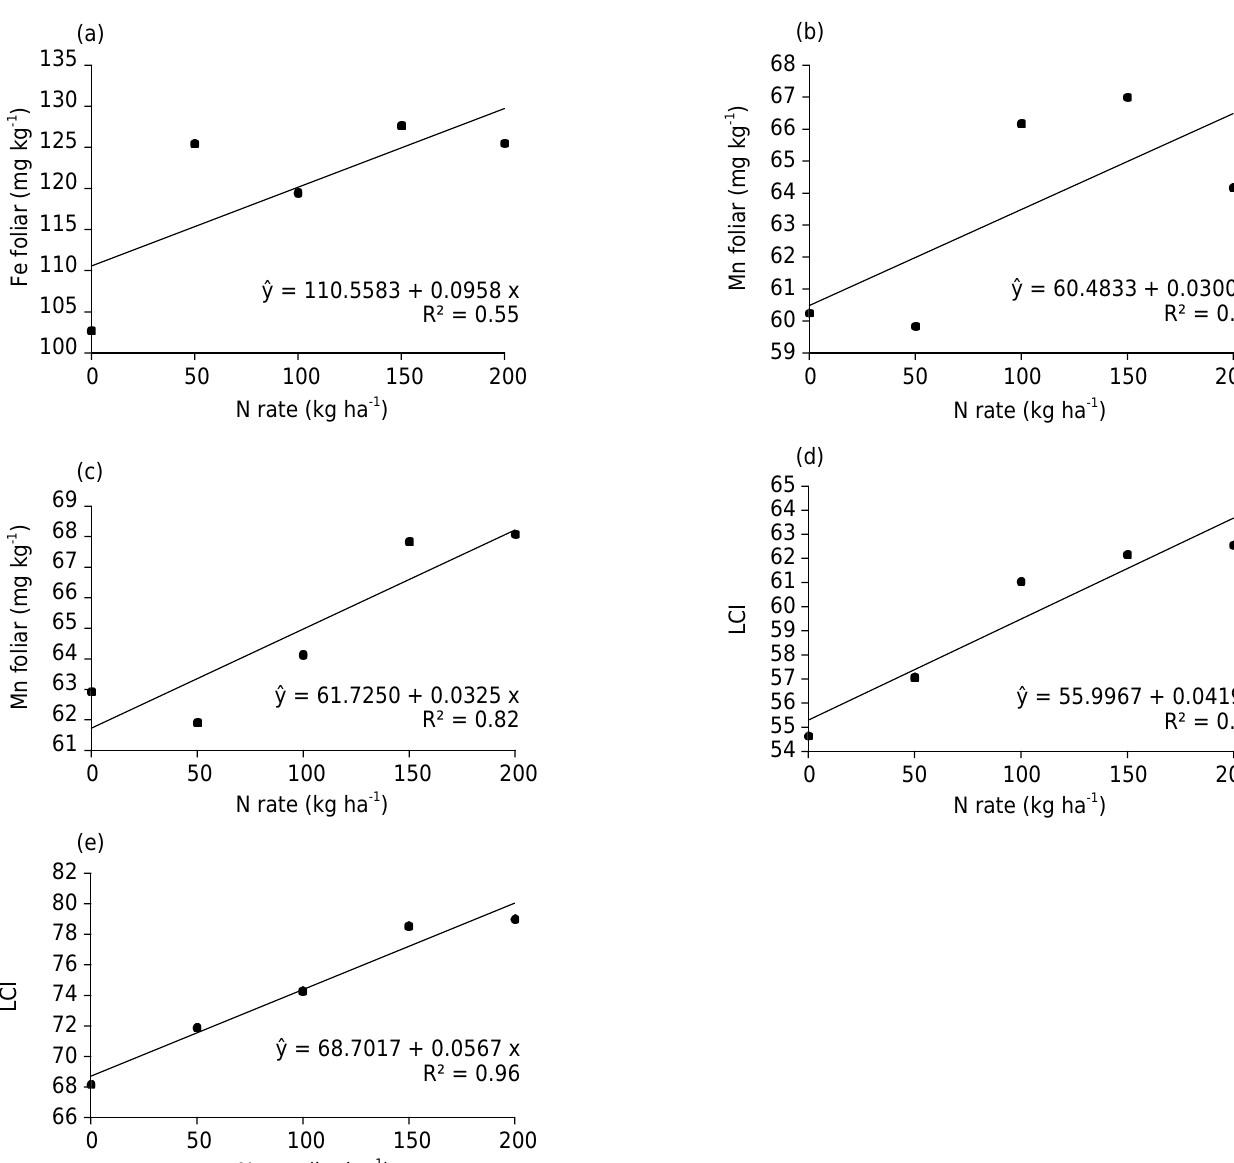
Figure 3. Concentrations of leaf iron in 2014/15 (a), leaf manganese in 2013/14 (b) and 2014/15 (c), and the leaf chlorophyll index (LCI) of corn affected by nitrogen rates in 2013/14 (d) and 2014/15